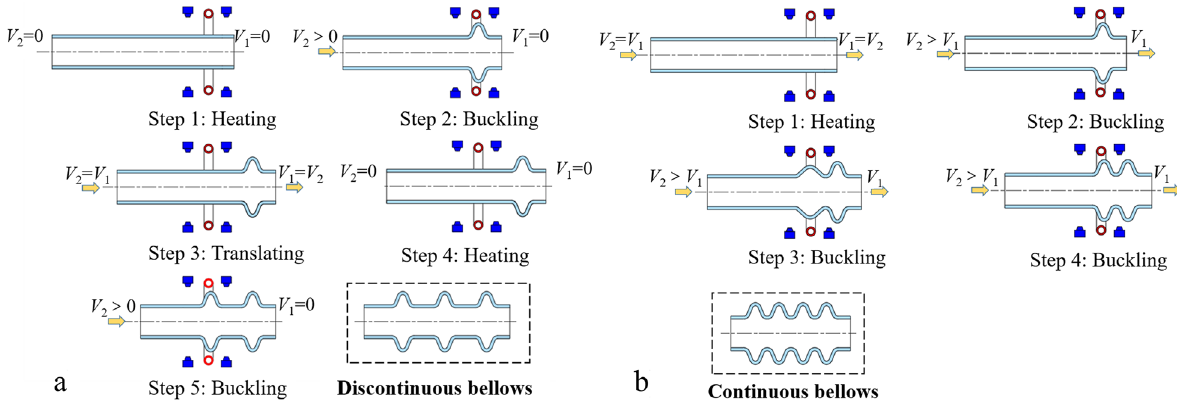
Figure 2 Schematic diagrams of thermal buckling-induced forming process: a Discontinuous bellow, b Continuous